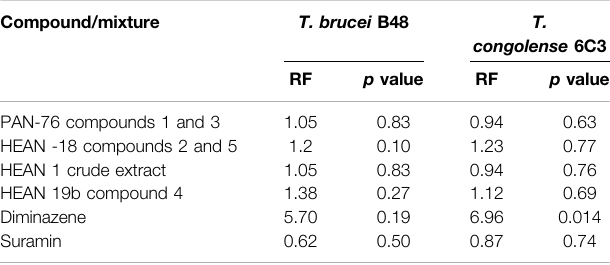
RF, resistance factor, being the ratio of the EC50 values of the resistant and control strains. p valuewas obtainedusing unpairedStudent ’ s testbetween theEC50 valuesof the resistant line and control, obtained in parallel ( n (cid:2)